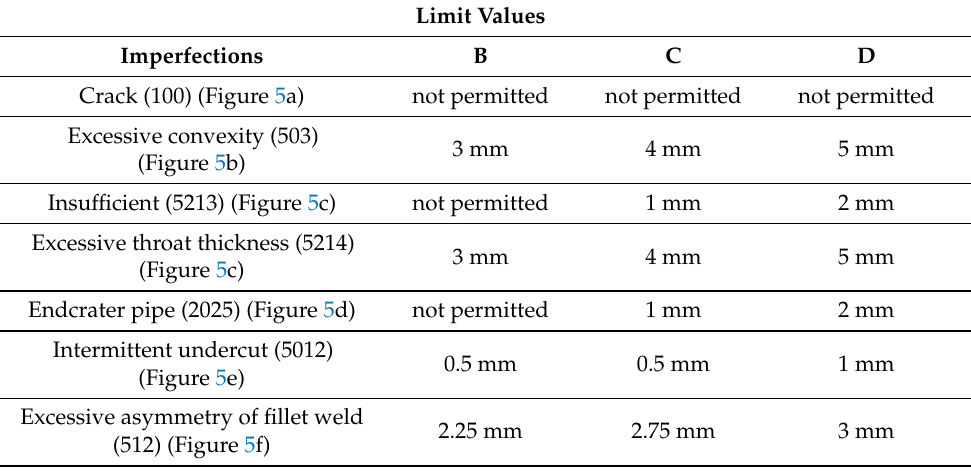
Table 2. Welding defects in fillet welds (according to ISO 5817)